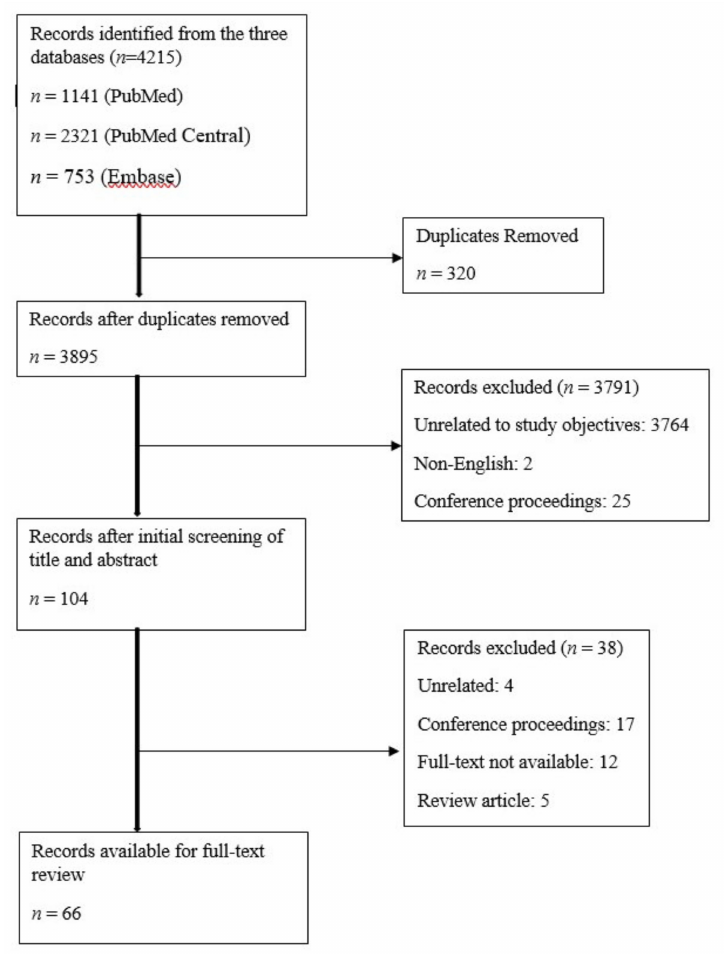
Figure 1. PRISMA